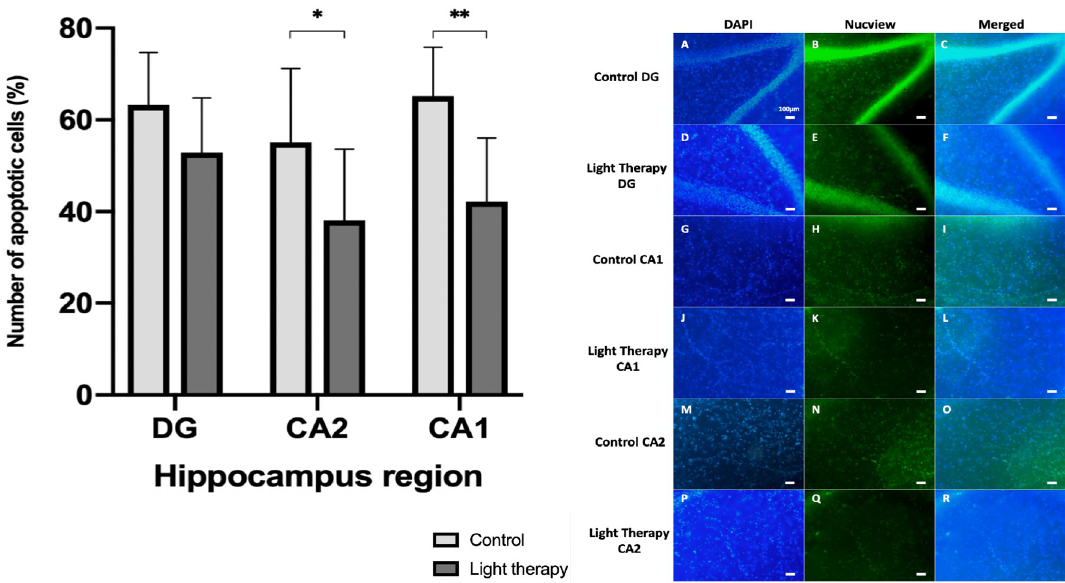
Fig 4. Differential effect of LT2 on the individual hippocampal regions observed. LT2 = 660nm irradiation for two minutes per day over a 5 day culture. �� denotes P < 0.01, � denotes P < 0.05, error bars represent SD. CA1 = cornu Ammonis 1, CA2 = cornu Ammonis 2, DG = dentate gyrus, DAPI = 4’, 6-diamidino-2-phenylindole.